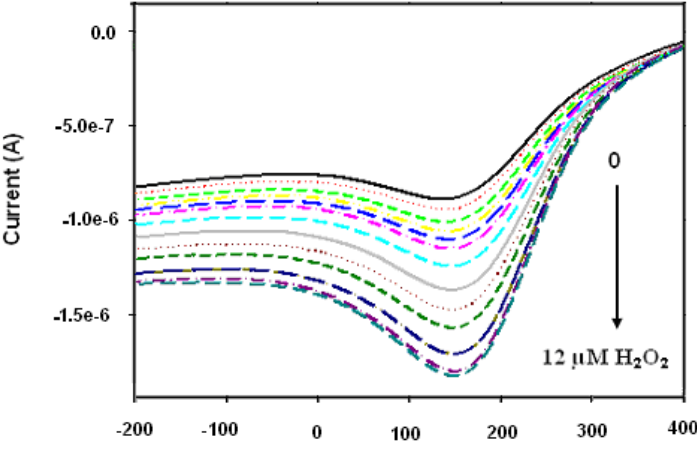
Figure 8. Square wave responses of Pt/PANI:PESA/HRP biosensor on the first day of biosensor preparation, i.e. , at 0